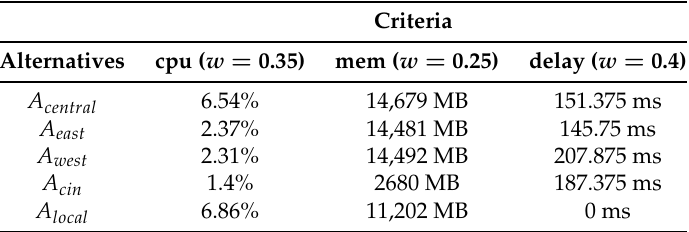
Table 1. Decision matrix with attribute values.